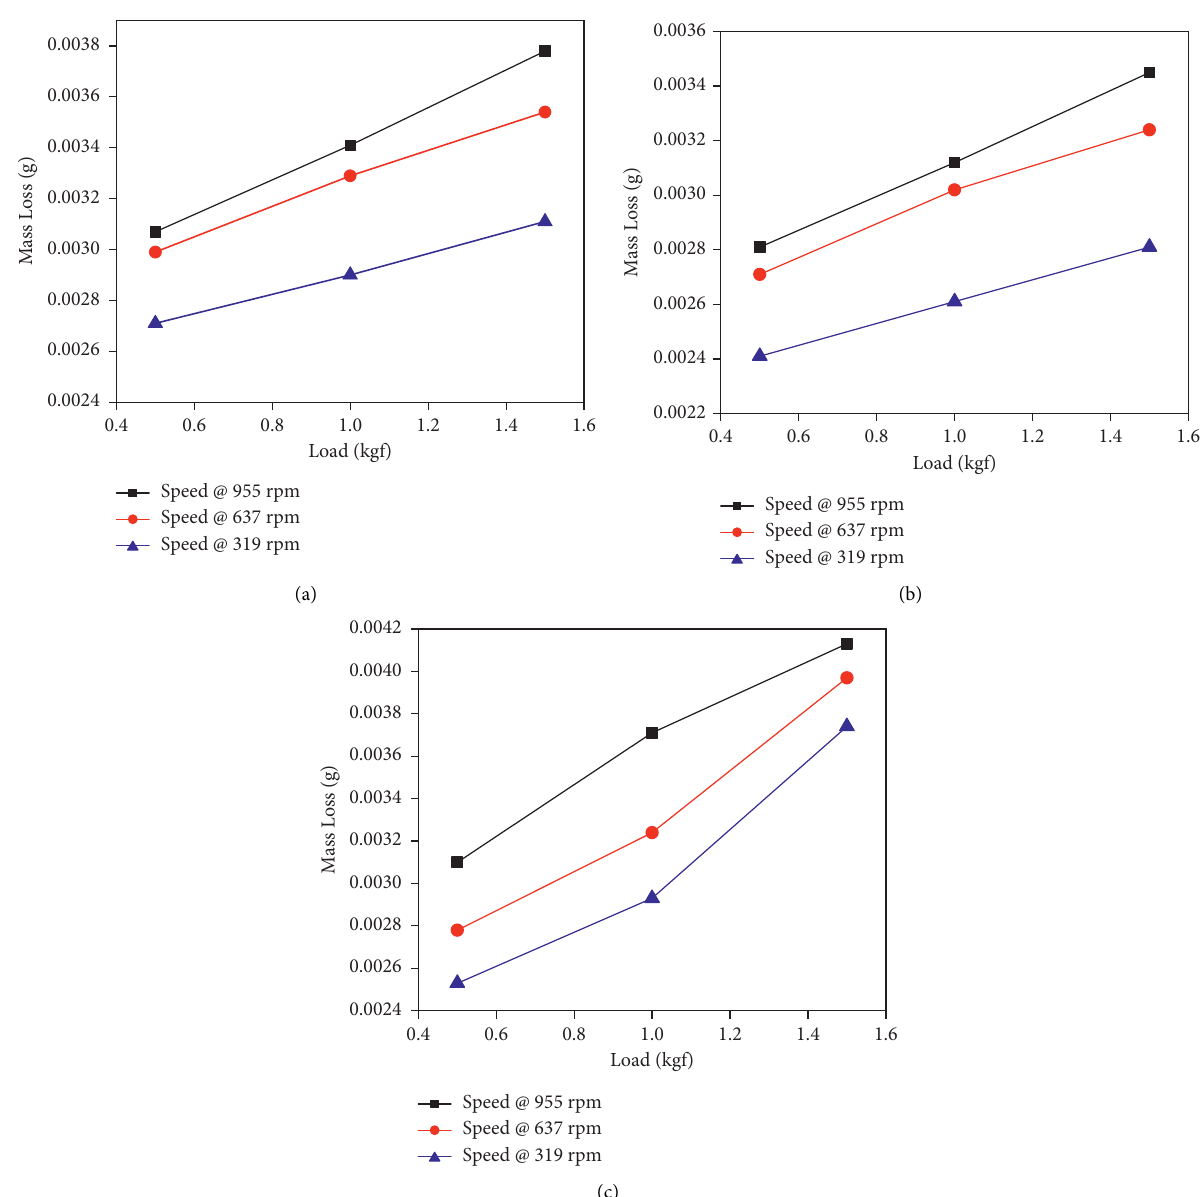
Figure 7: Mass loss measured during the experimentation with Al 2 O 3 +TiO 2 coating for different rotational speeds: (a) Al 2 O 3 +TiO 2 +1% CNT, (b) Al 2 O 3 +TiO 2 +3% CNT, and (c) Al 2 O 3 +TiO 2 + 5%